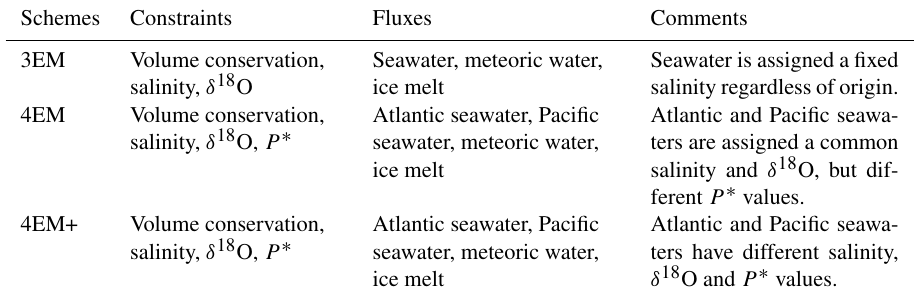
Figure 2. Sections of δ 18 O (a) , salinity (b) , P ∗ (c) and volume flux from Tsubouchi et al. (2012) (d) after optimal interpolation onto the Tsubouchi et al. (2012) CTD station positions, clockwise around the four gateways from Davis Strait to Bering Strait. Solid black lines indicate the potential density ( σ ) surfaces separating the main Arctic water masses grouped as follows: surface water ( σ 0 < 26 . 0), subsurface water (26 . 0 < σ 0 < 27 . 1), upper Atlantic water (27 . 1 < σ 0 < 27 . 5), Atlantic water ( σ 0 = 27 . 5 to σ 0 . 5 = 30 . 28), intermediate water ( σ 0 . 5 = 30 . 28 to σ 1 = 32 . 75) and deep water ( σ 1 > 32 . 75); definitions from Tsubouchi et al. (2012). Note the broken scaling of the y axis. Table 1. Description of the three model schemes.